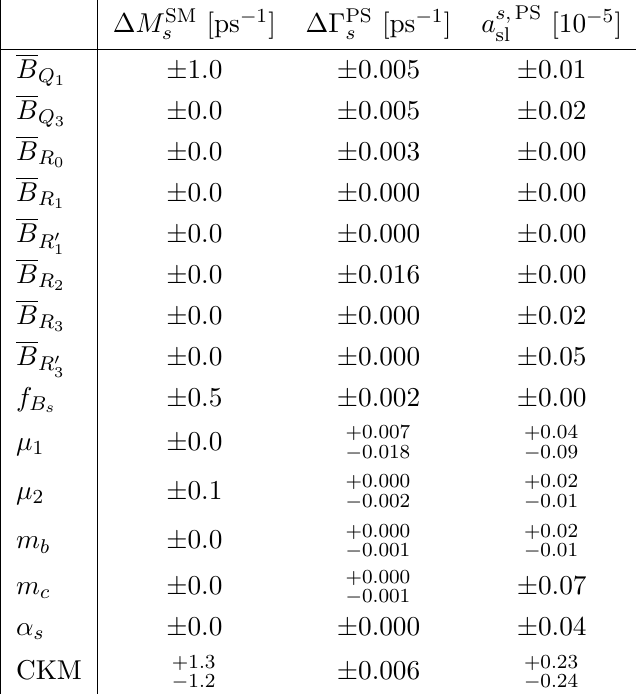
Table 6 . Individual errors for the B s mixing observables.